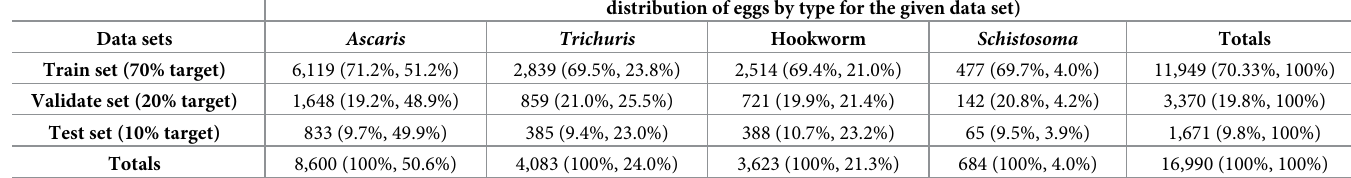
Table 2. Number of parasite eggs used in the training sets. Distribution of eggs by type and data set after random shuffling (distribution of eggs by data set for the given egg type, distribution of eggs by type for the given data set)